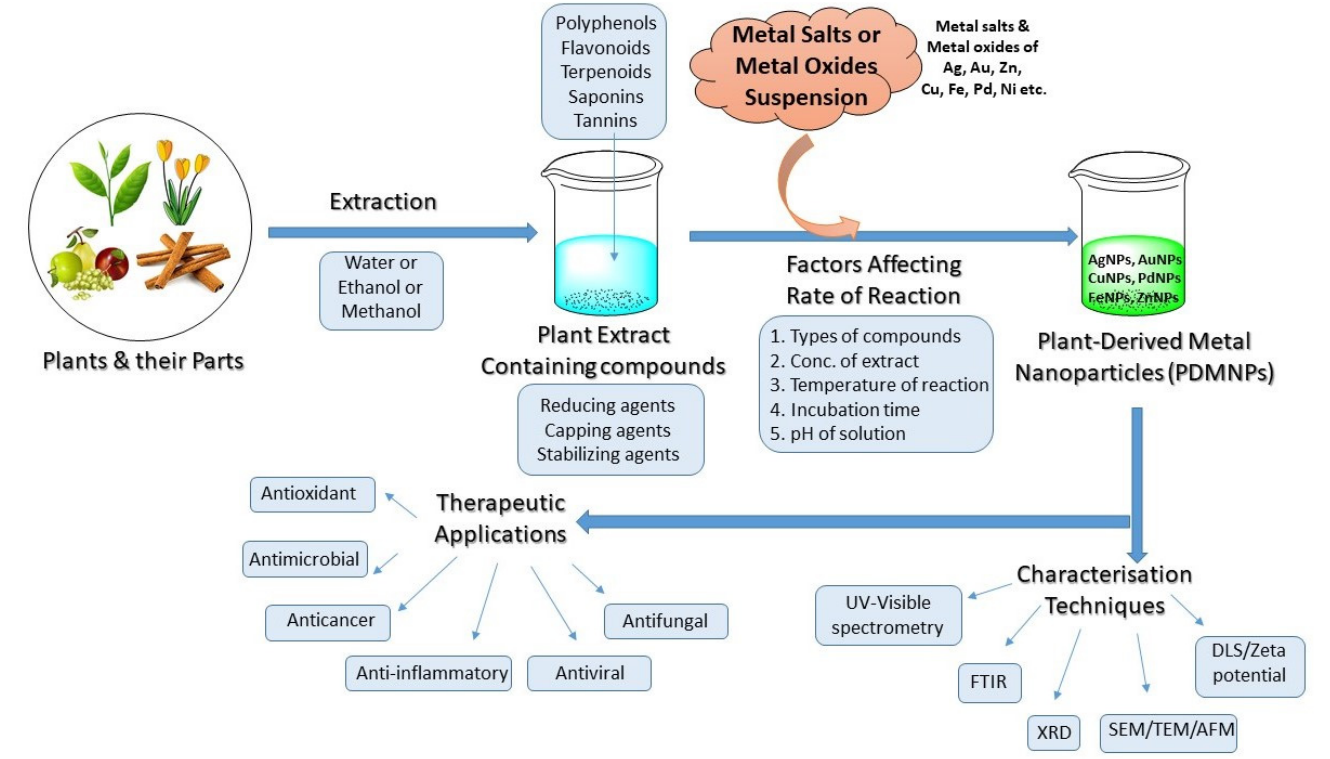
Figure 1. Schematic diagram showing the strategies for the synthesis, optimization of reactions, characterization, and therapeutic applications of PDMNPs. characterization, and therapeutic applications of